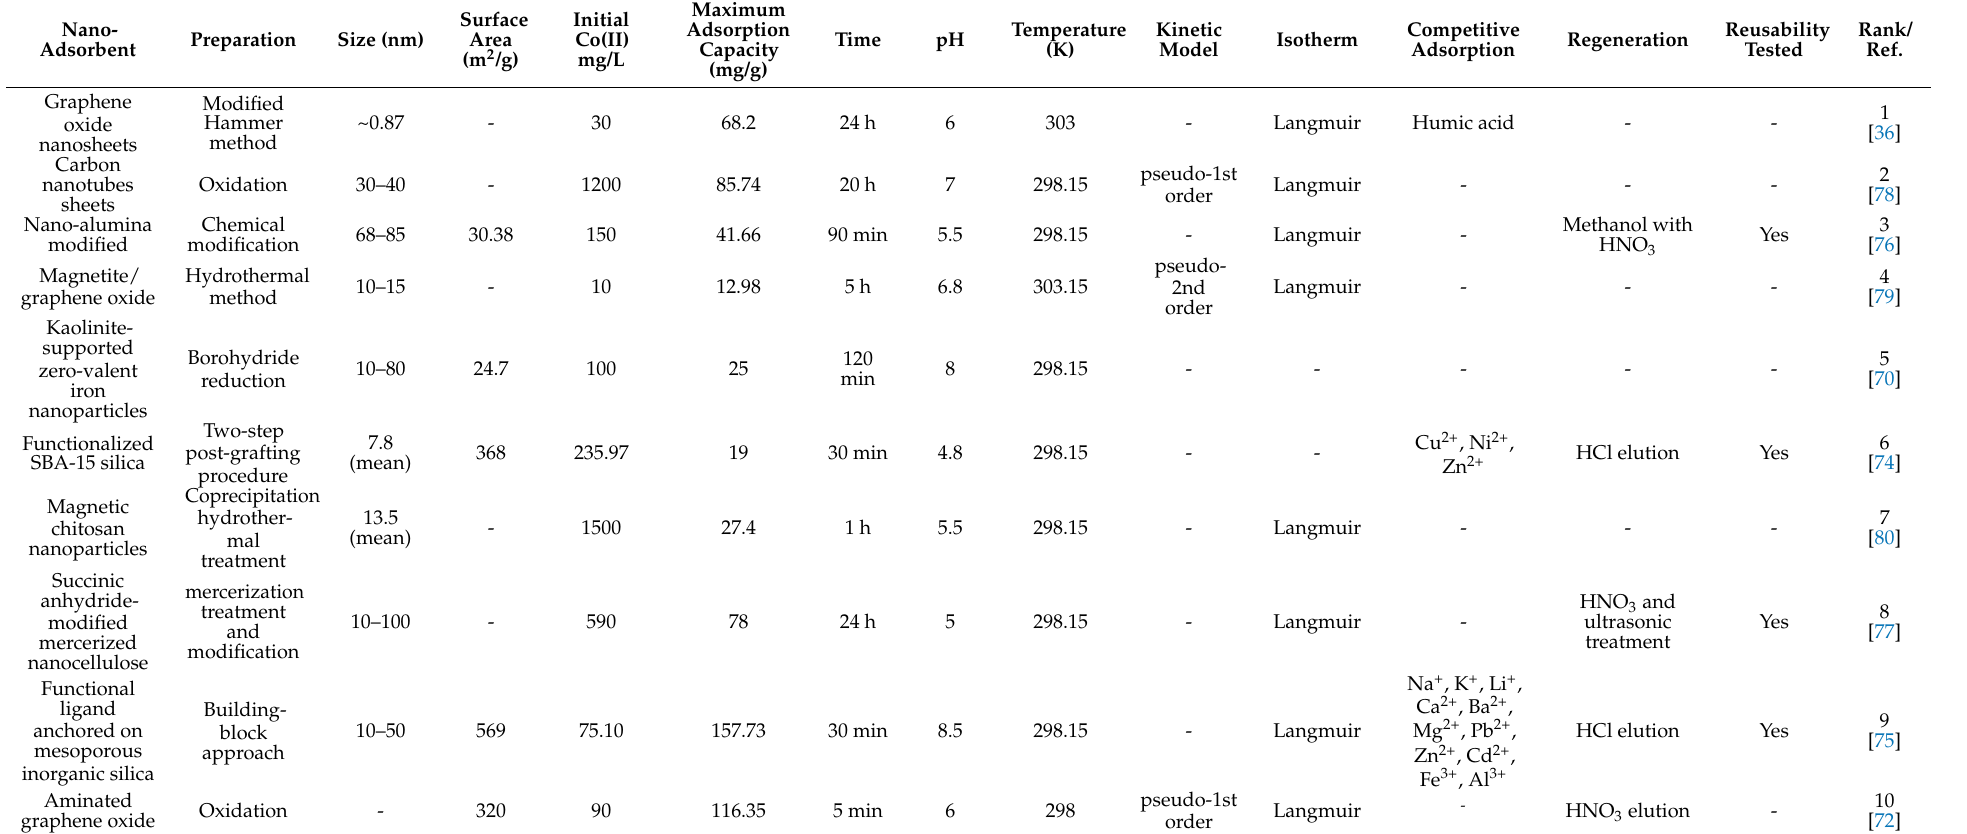
Table 7. Cobalt adsorption insights of the top 10 cited research